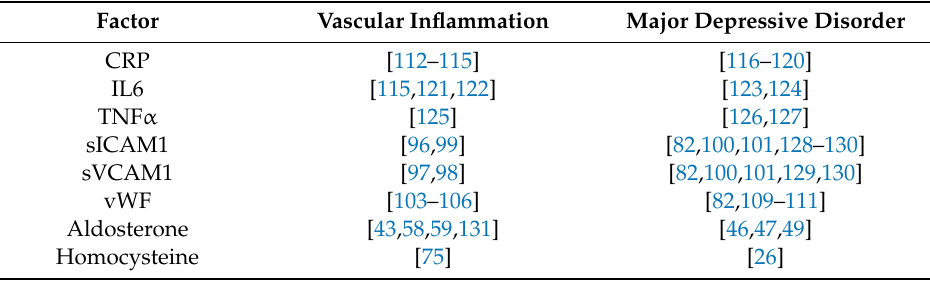
Table 1. Potential Biomarkers for Depression Caused by Vascular